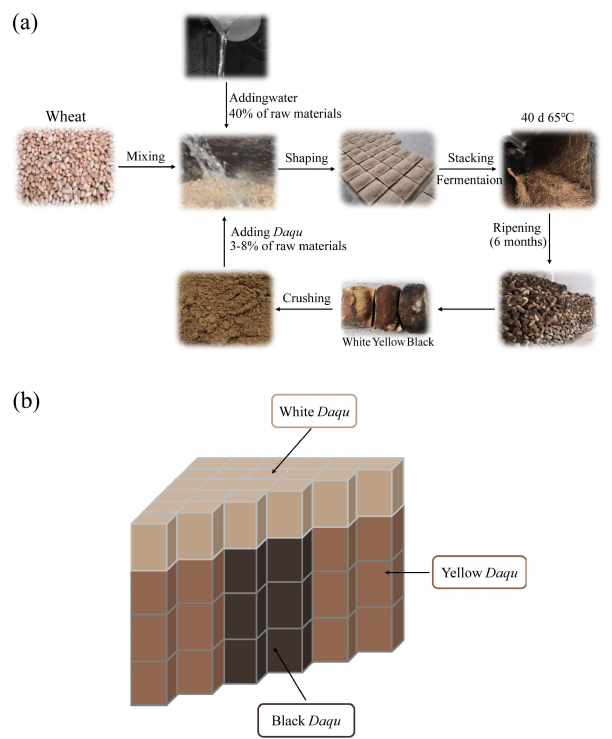
Figure 1. Preparation of Daqu for sauce‑flavored baijiu. ( a ) The manufacturing process of Daqu for sauce‑flavored baijiu. ( b ) Characteristic diagram of the three different types of high‑ temperature Daqu